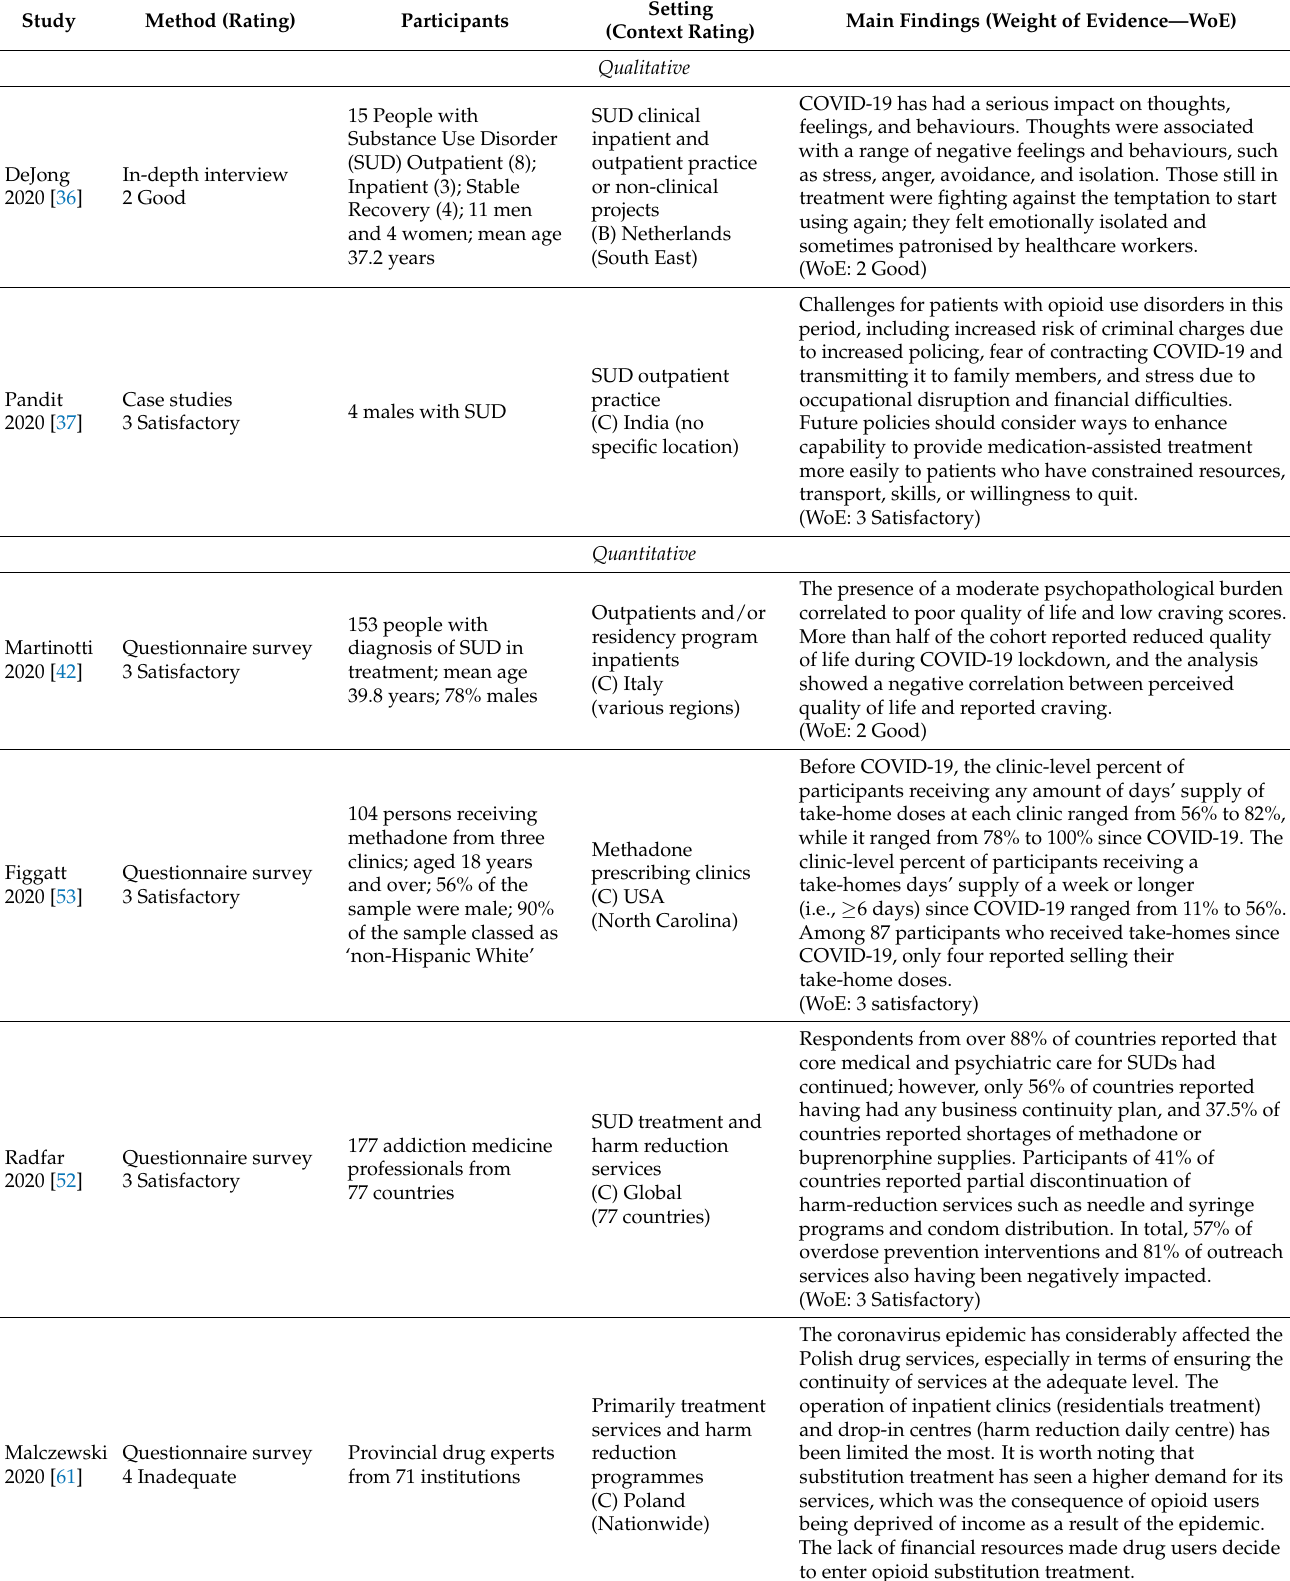
Table 5. Treatment